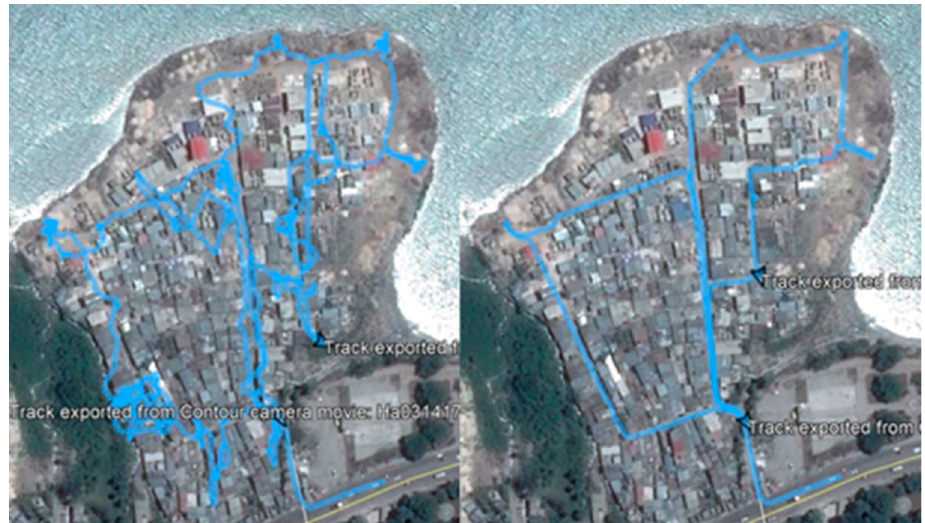
Figure 3. Maps displaying GPS (global positioning system) path corrections in the EC study area. In each image, the blue line shows the walking path connecting test locations. The path on the left is the GPS extracted from the camera. The path on the right has been corrected.